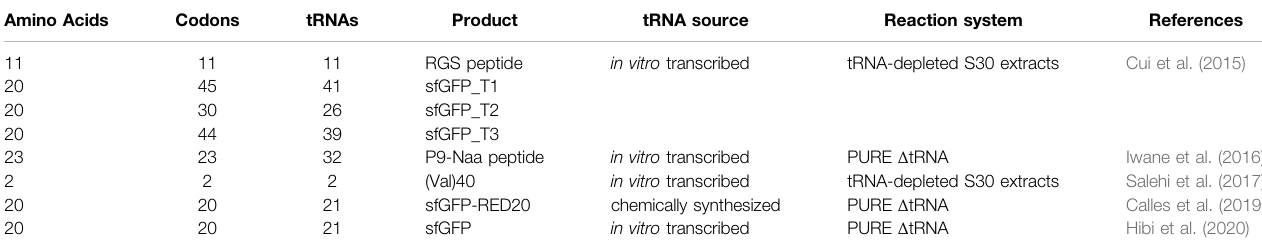
TABLE 2 | A reduced set of tRNA used for protein synthesis based on the cell free system. Amino